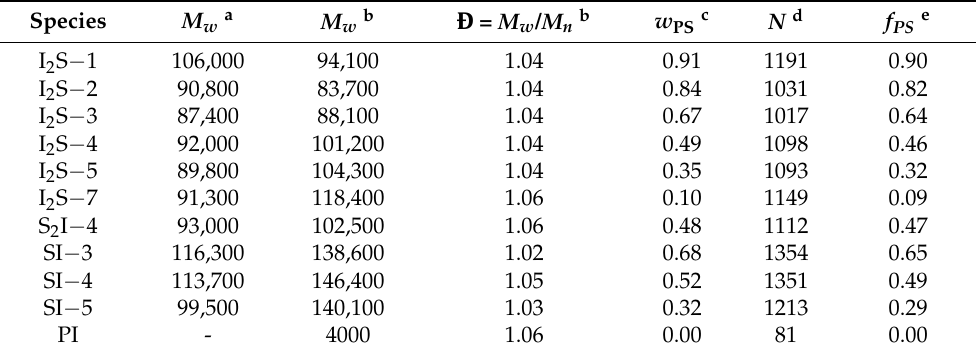
Table 1. Molecular characteristics of (polyisoprene) 2 (polystyrene), (polyisoprene)(polystyrene) 2 single graft copolymers, and polyisoprene-b-polystyrene linear copolymers.